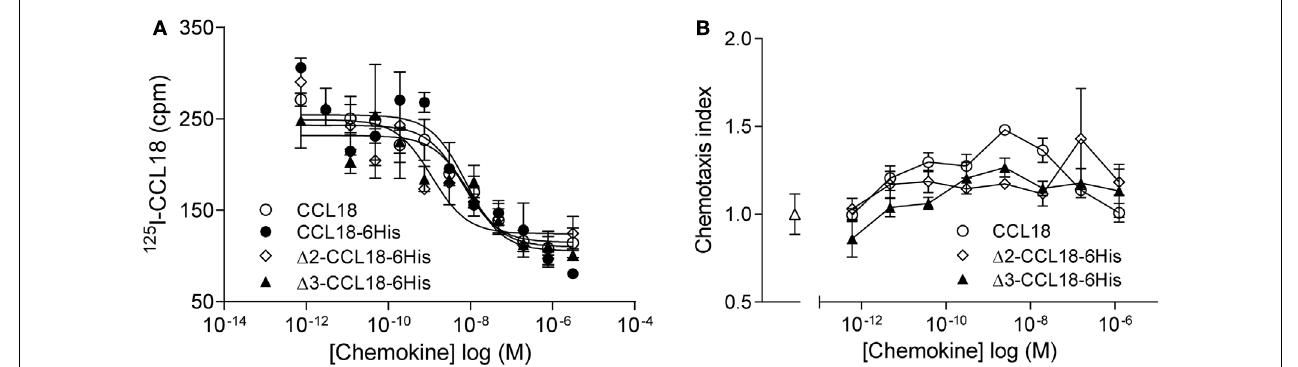
points are in triplicate.The graph represents a single experiment. (B) In vitro chemotactic response of PBL to CCL18 and the N-terminal truncated forms ∆ 2-CCL18-6His and ∆ 3-CCL18-6His. Medium ( ∆ ) was used as a control. Data are expressed as chemotaxis index ± SEM. Data points are in triplicate. One representative experiment out of three is